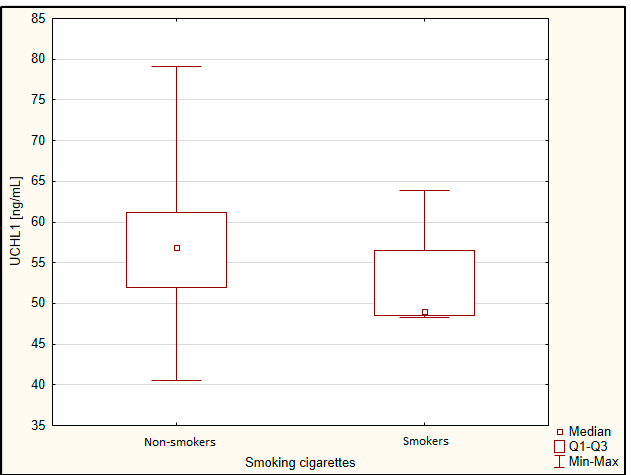
Figure 2. Concentration of UCHL 1 depending on smoking cigarettes. Q1, lower quartile; Q3, upper quartile.